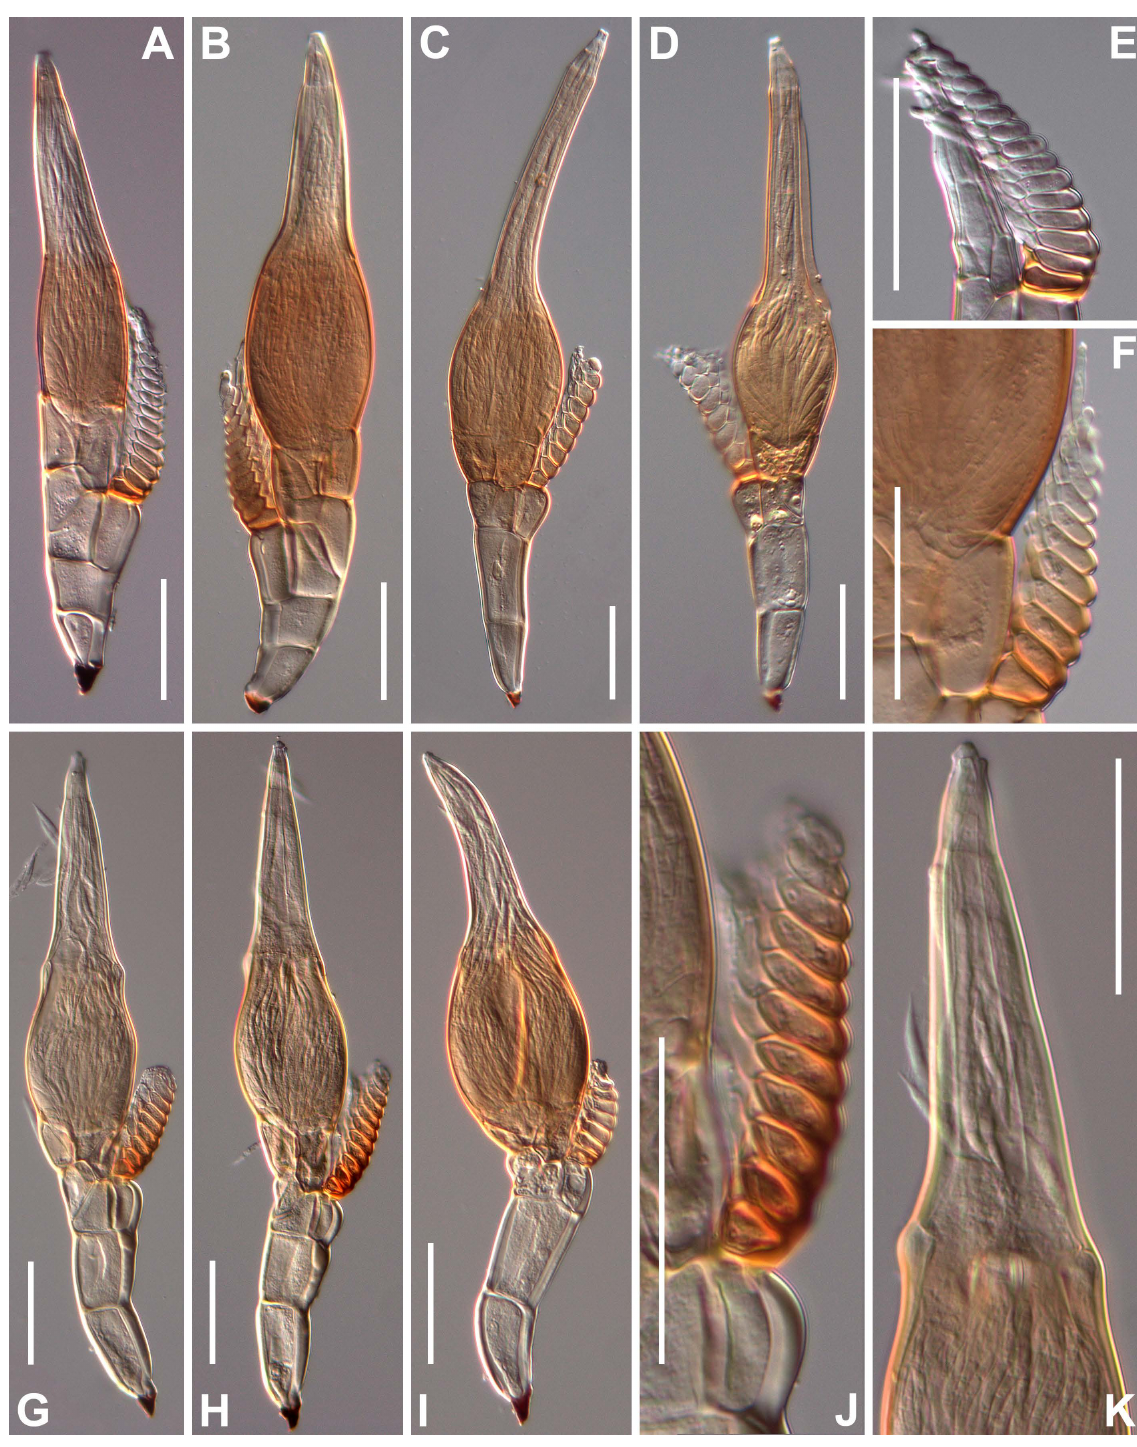
Fig. 57. Stigmatomyces spp. A – F . S. crassicollis Thaxt. A – D . Mature thalli, from Leptocera fontinalis (A–B), from Spelobia luteilabris (C), and from Spelobia rufilabris (D). E – F . Primary appendages in detail. – G – K . S. divergatus Thaxt. G – I . Mature thalli. J . Primary appendage in detail. K . Perithecial tip in detail. Scale bars: 50 µm. Photographs from slides ZMUC C-F-124097 (A, E), ZMUC C-F-124017 (B, F), ZMUC C-F-124018 (C), ZMUC C-F-124019 (D), ZMUC C-F-123720 (G–H, J–K), ZMUC C-F- 123717